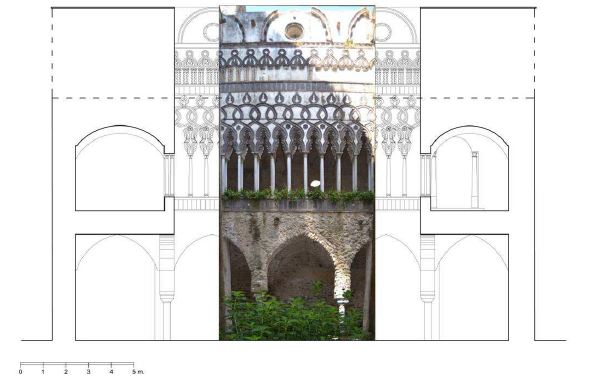
Figure 6. Section of the courtyard with orthophotos Wall